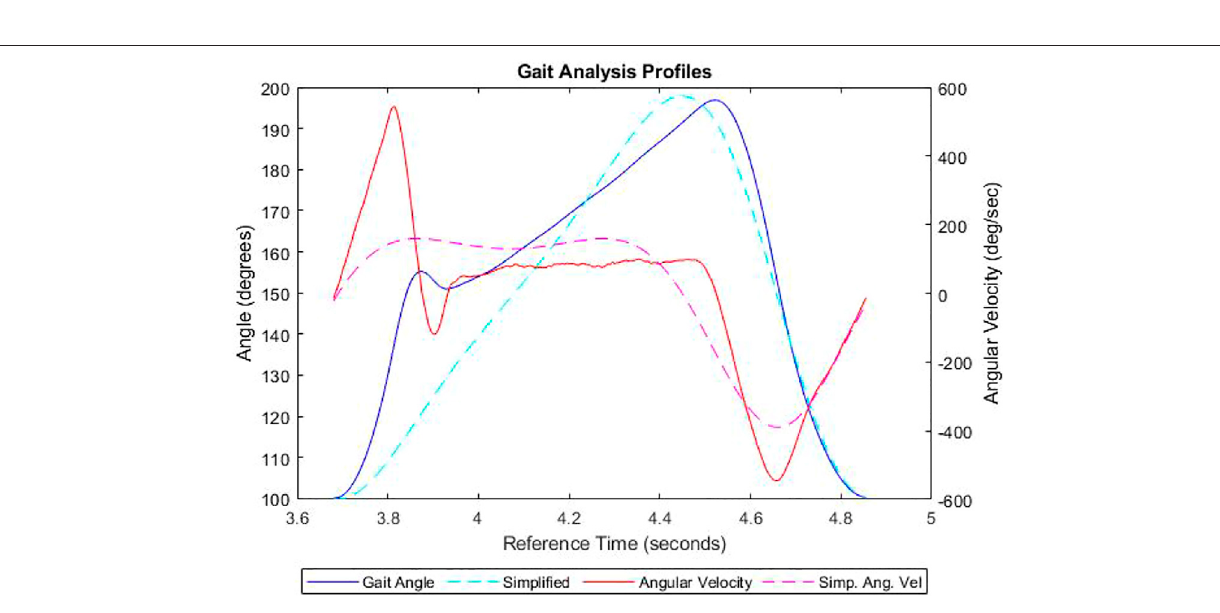
Frontiers in Robotics and AI |